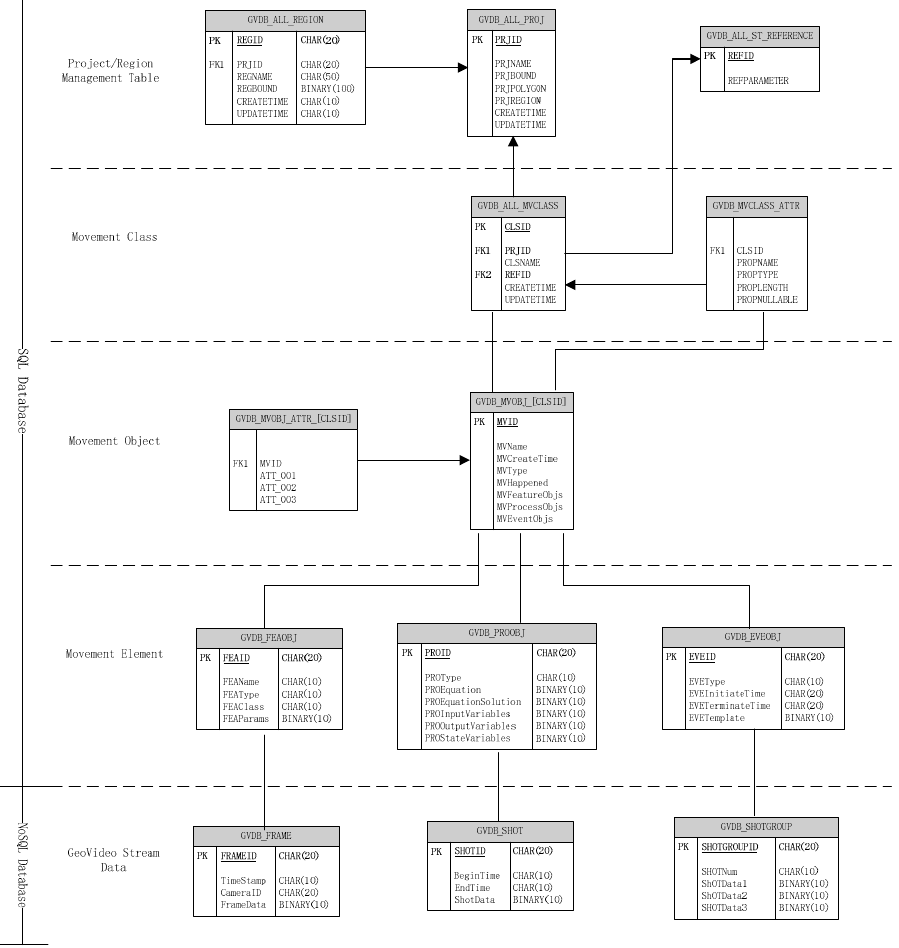
Figure 3. The hierarchical structure of the GeoVideo database.